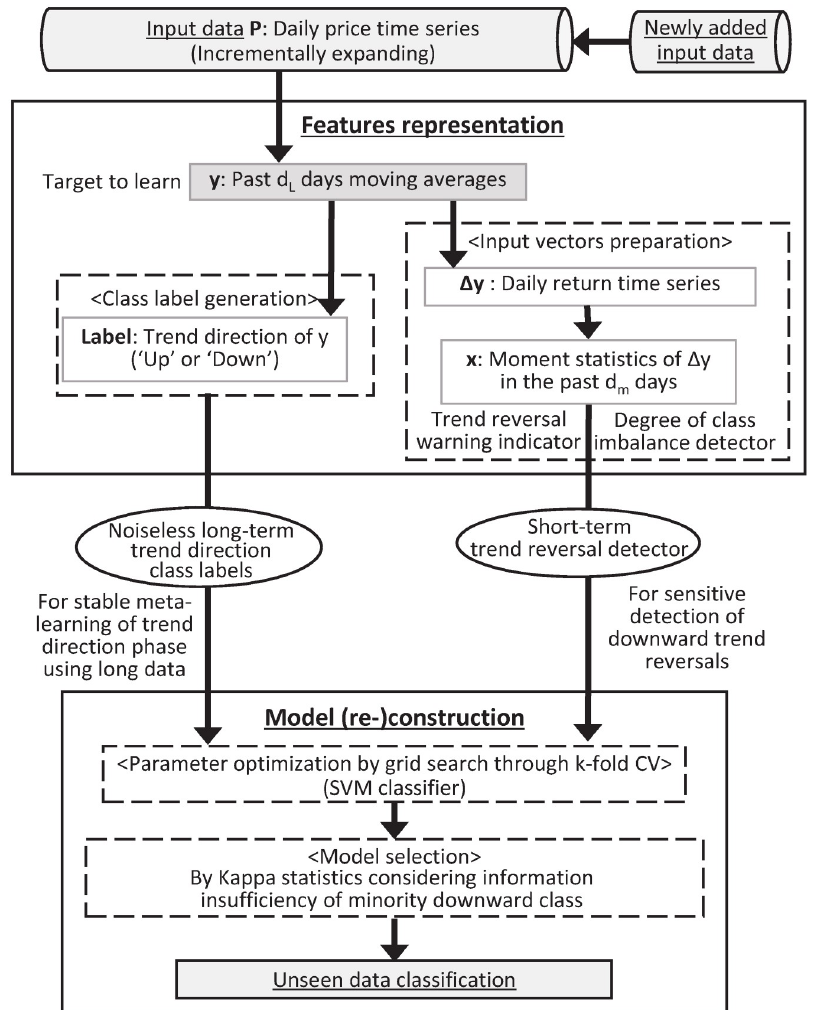
Fig 1. Schematic layout of the long-term trend direction classification method. high-dimensional feature space using linear classification. The learned classification rule is then mapped back to the original input space. The standard model, C-support vector classifica- tion, is as follows. Consider the training dataset x composed of N input vectors x responding to target labels y , � � � , y , where y 2 { − 1, + 1}. We set labels y 1 N trend direction is downward (upward). Let ϕ ( x ) denote a fixed feature space transformation for some weight vector w and bias parameter b . Then, the binary soft margin classification problem is